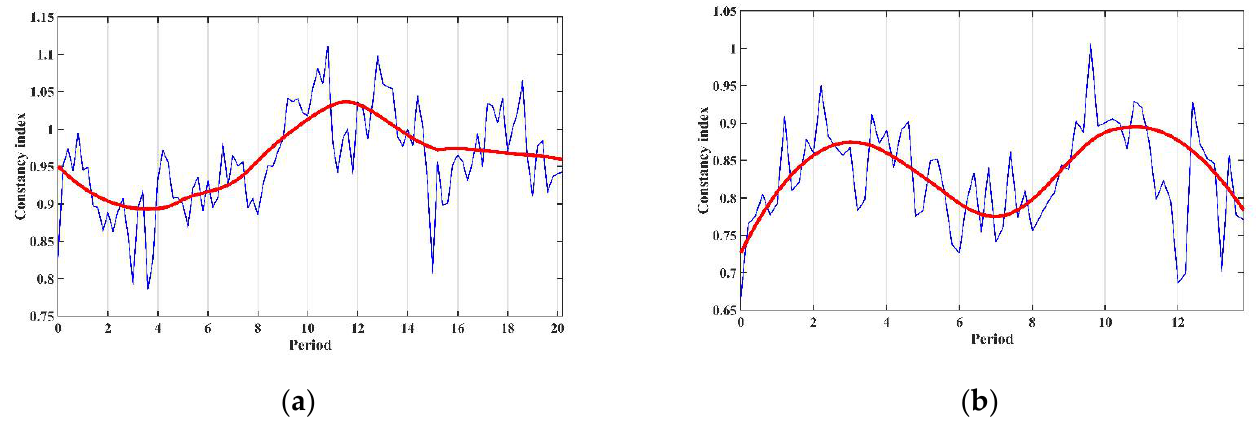
Figure 7. The results of applying the developed DMA-algorithm to identify the periods in the magnetic susceptibility data for rocks of Zhelezny Rog Cape: ( a ) Lower-Upper Pontian deposits; ( b ) Lower Maeotian deposits. The calculated constancy exponent of the series is shown in blue (construction—dispersion, see above). The ‘strongly’ smoothed version is shown in red.